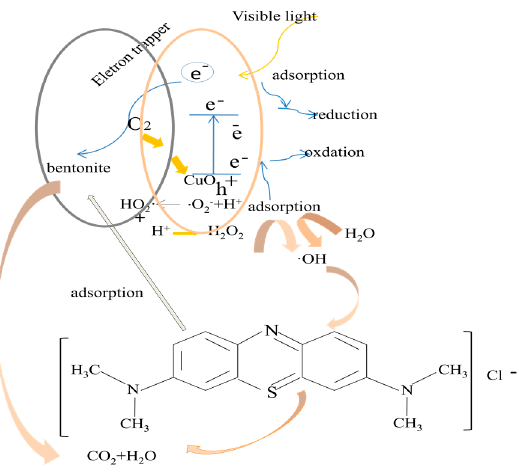
Figure 11. Photocatalytic degradation mechanism diagram of CuO/bentonite composite.